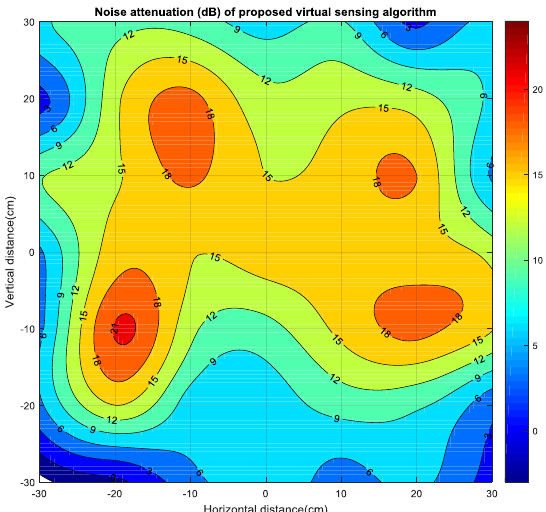
Figure 8. The quiet zone generated by multichannel ANC with the proposed virtual sensing algorithm in a stable environment.